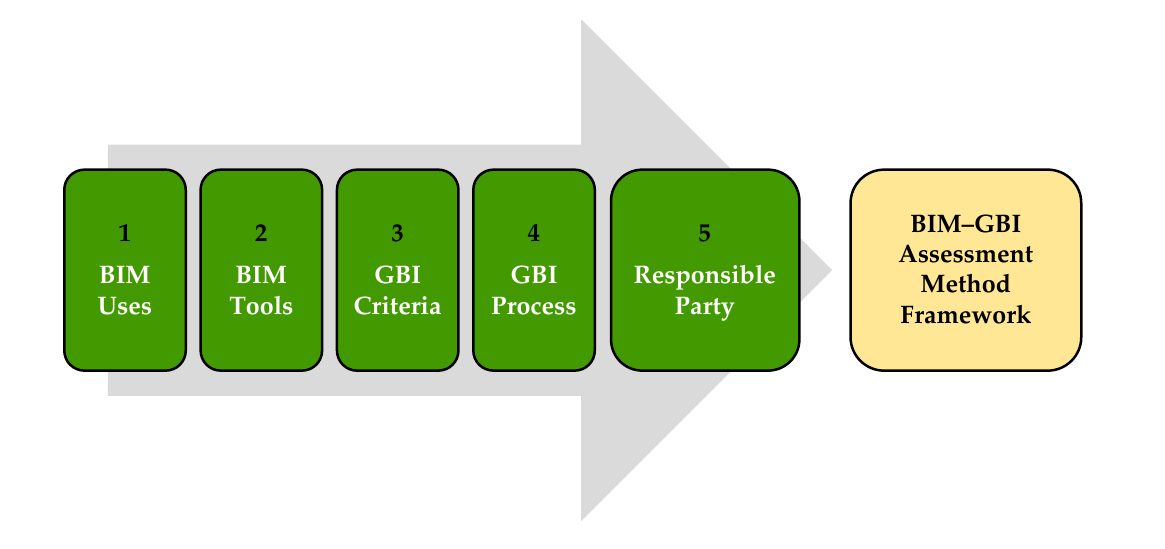
Figure 1. BIM–GBI assessment method framework.